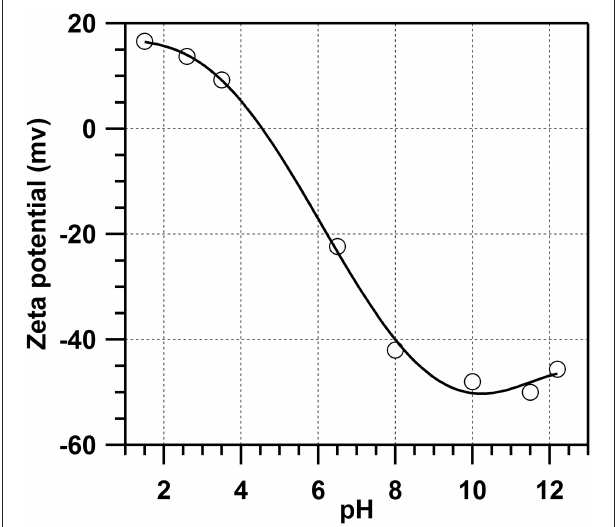
FIGURE 3 | Zeta potential of MK-water dispersion in solution with different pH value.